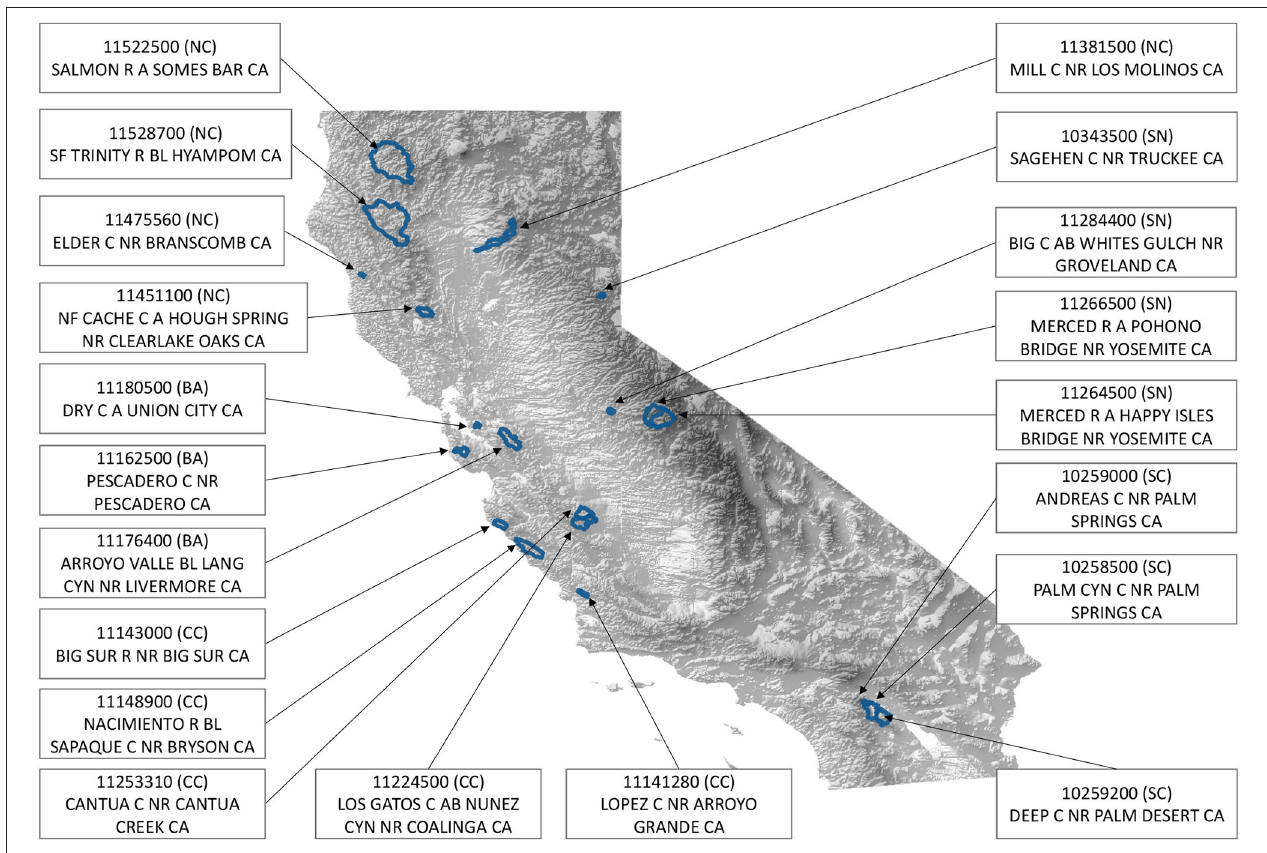
FIGURE 1 | A topographic plot of California and the 20 watershed regions considered in this